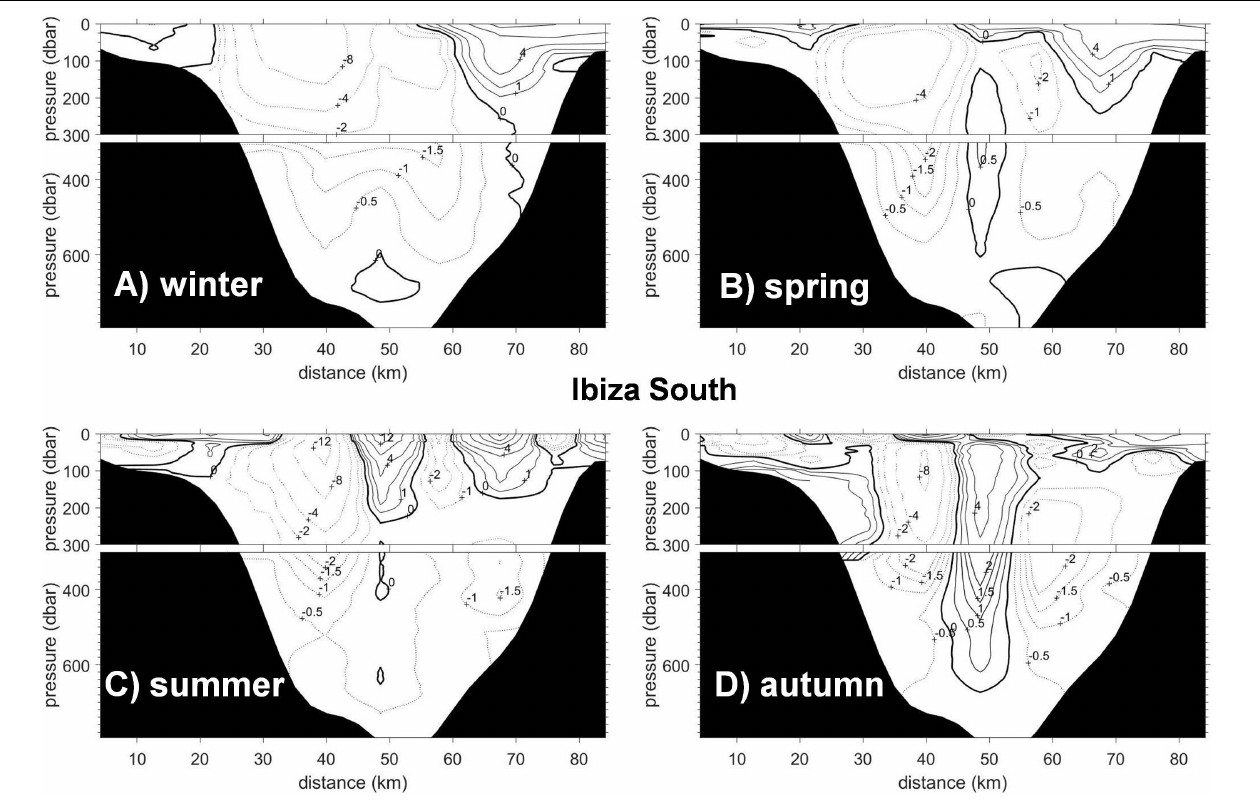
FIGURE 10 | Cross section absolute geostrophic velocity (in cm/s) at the Ibiza South section for winter (A) , spring (B) , summer (C), and autumn (D) . Solid lines correspond to positive velocities which are directed to the North (into the paper), while negative velocities are represented by dashed lines and are directed to the South (out of the paper). The velocity contour intervals for the upper 300 dbar are 0, 1, 2 4, 8, 12, 16, and 20 cm/s (both positive and negative). The contour interval for the velocity from 300 dbar to the sea bottom are 0, 0.5, 1, 1.5 and 2 cm/s (both positive and negative).